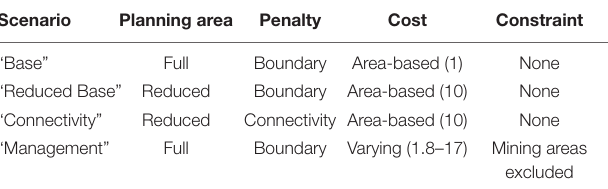
TABLE 2 | Characteristics of the implemented scenarios.